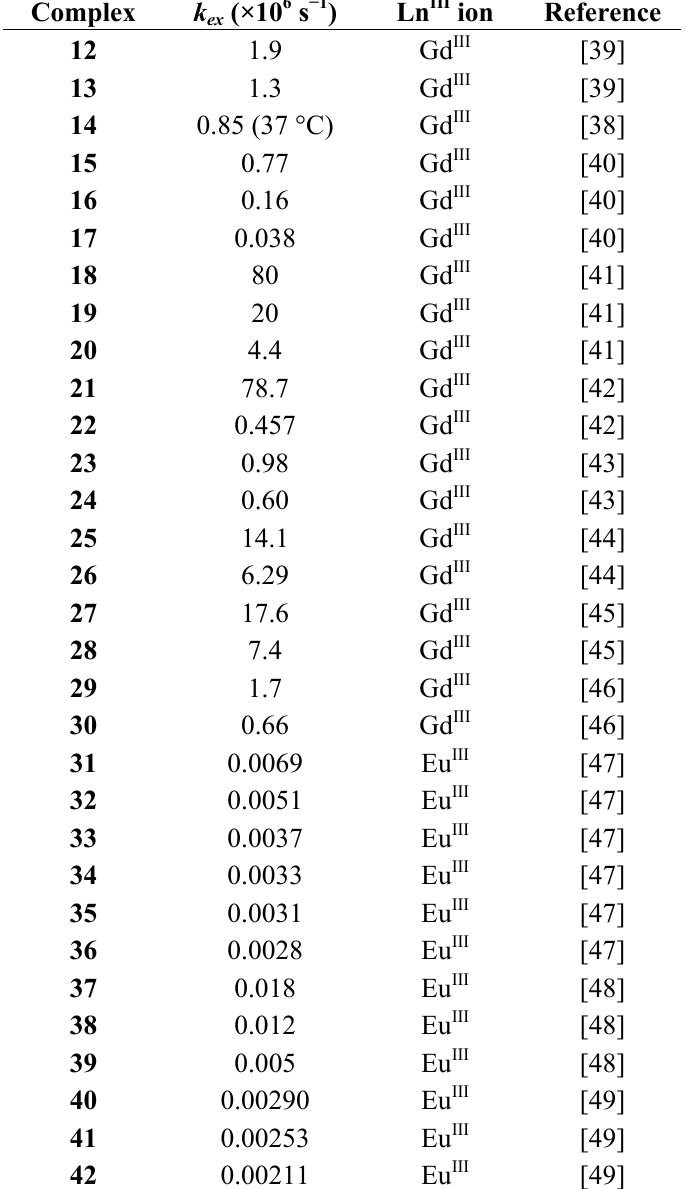
Table 2. Water-exchange rates of complexes 12 – 42 discussed in section 2.2, determined from 17 O-NMR spectroscopy and CEST spectra for Gd III - and Eu III -containing complexes,